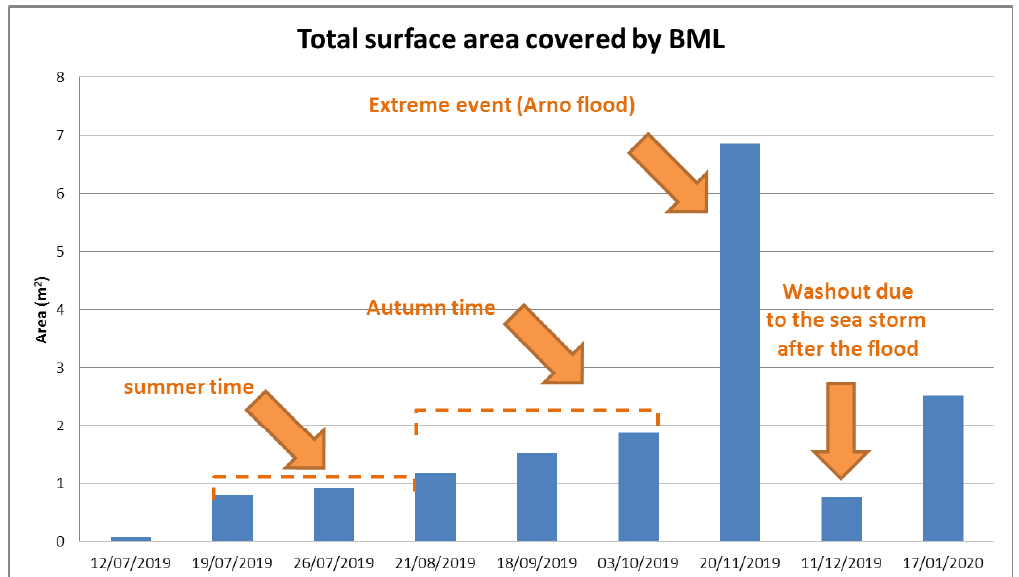
Figure 11. Histogram of the total surface area covered by BML for the different survey dates of the temporal period summer – autumn. Note that the time gap between different dates is not constant.